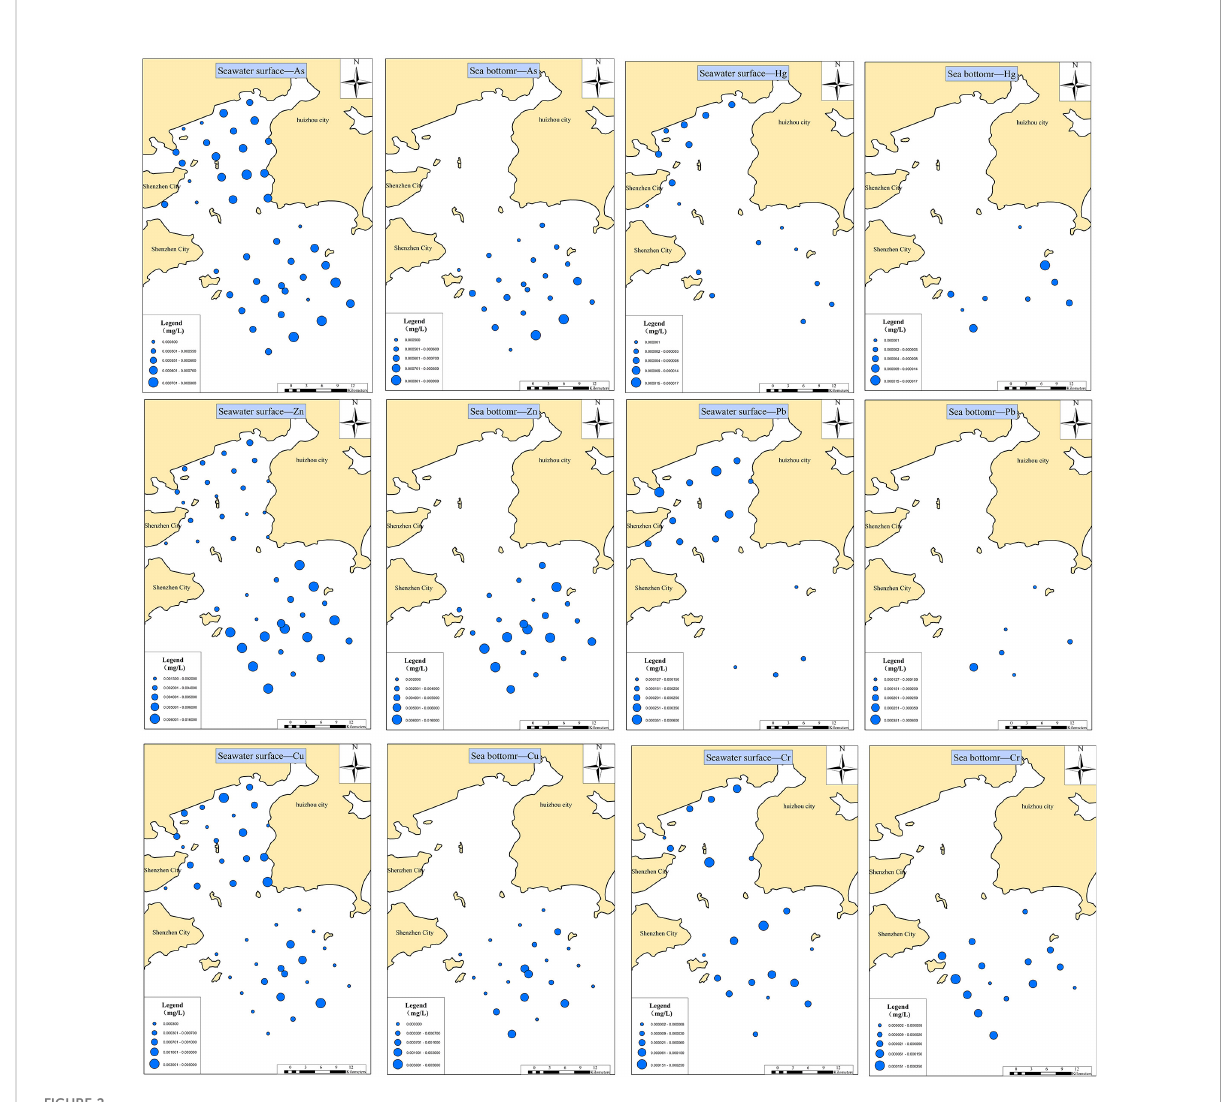
FIGURE 2 Concentration distribution of heavy metals in the seawater of Daya